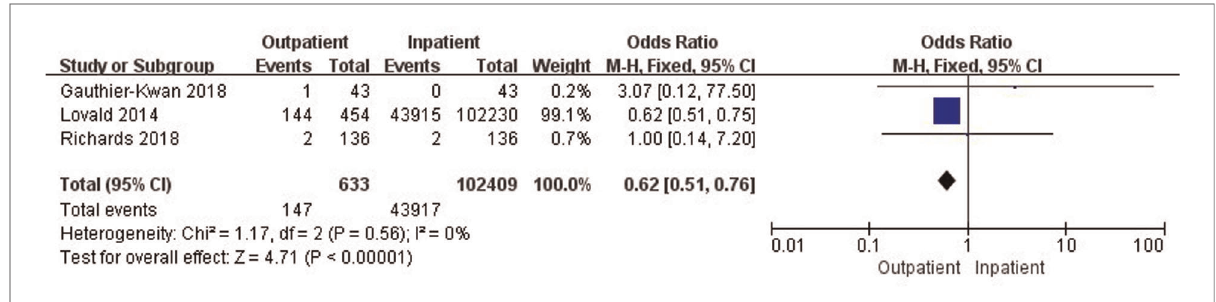
FIGURE 11 Comparison of 90-day surgical-related pain between outpatient and inpatient